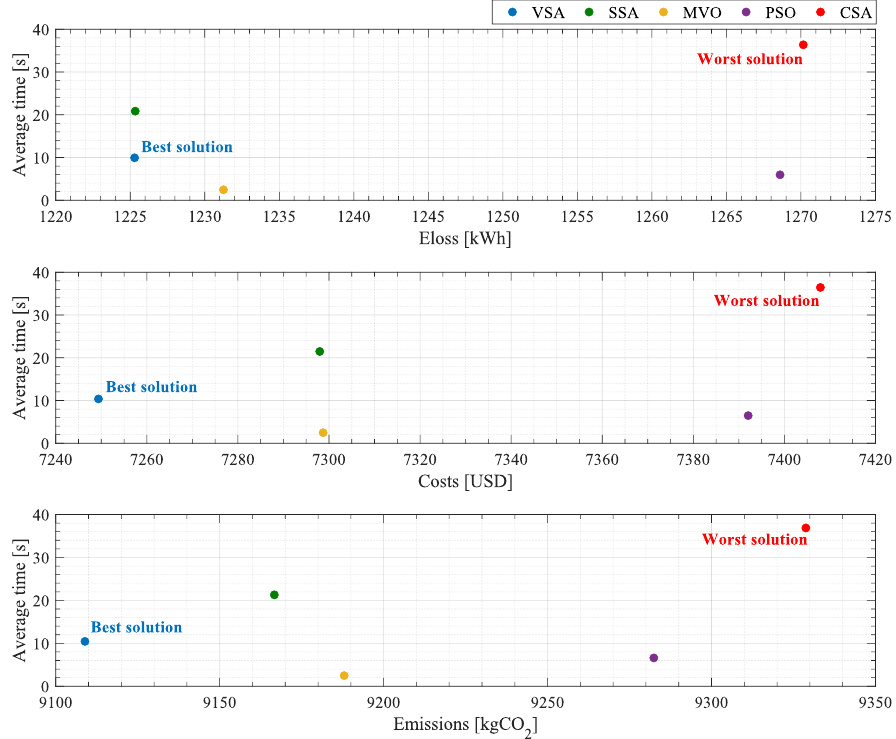
Figure 10. Trade-off provided by the optimization algorithms between objective function and required processing time in the grid-connected